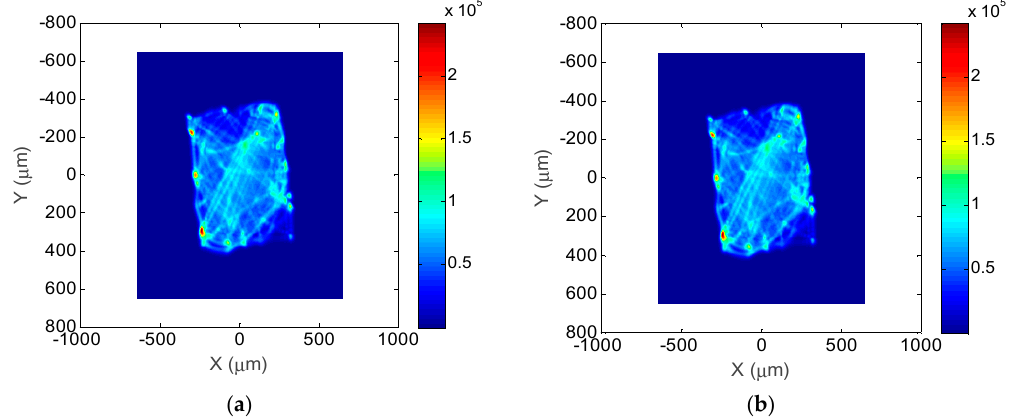
Figure 8. Far field distribution of the prescribed surface and plasma-processed surface: ( a ) Far-field distribution of prescribed surface; ( b ) Far-field distribution of plasma-processed surface.